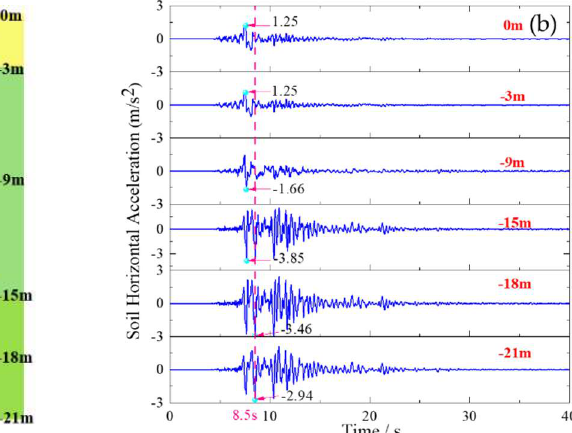
Figure 11. Acceleration Fourier spectra at different depths under the El-Centro motion.